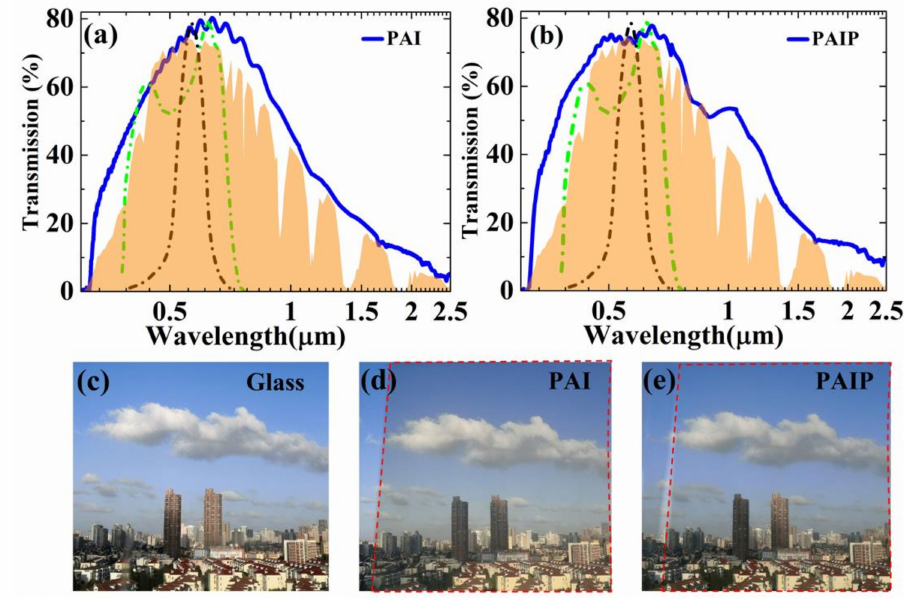
Figure 3. Solar range spectrum of samples. ( a ) Transmission spectrum of the PAI sample. ( b ) Transmission spectrum of the PAIP sample. The green line represents the plant response spectrum, the black line represents the human eye response spectrum, and the yellow area represents the normalized AM1.5 solar spectrum. ( c ) Transparency illustration of glass. ( d , e ) Transparency illustration of PAI and PAIP sample under the same surroundings (area in red dot